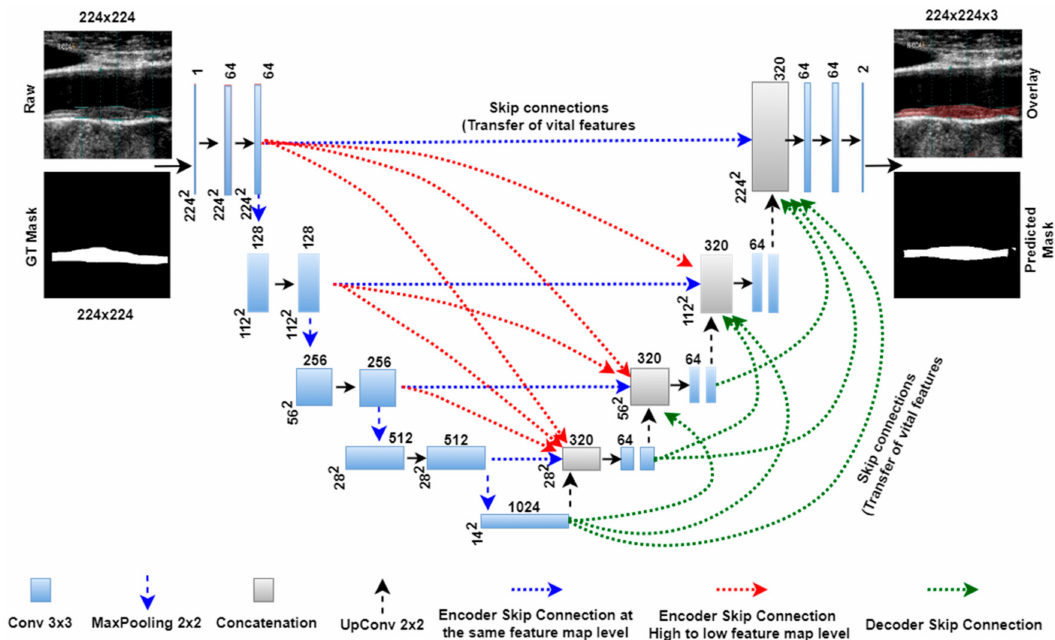
Figure 4. Unet3P model with four encoder and decoder